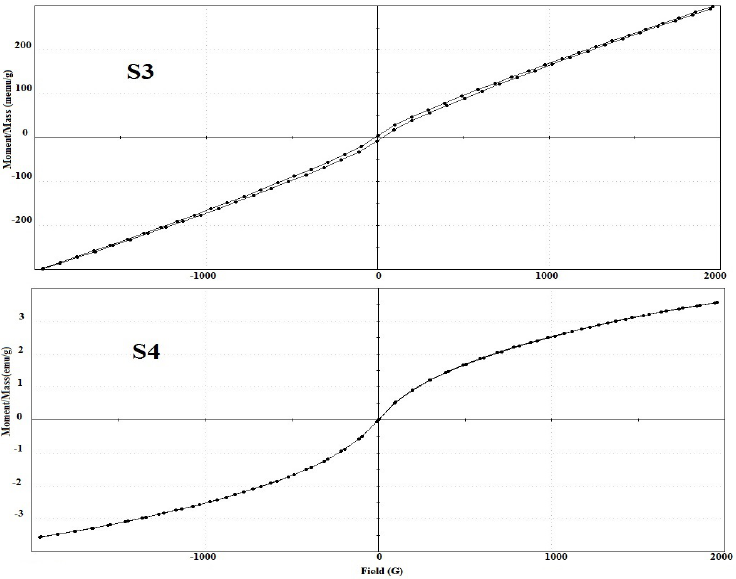
Figure 7. M - H curves for the S3 and S4 samples. Table 3. The magnetic properties (M s, M r , M r /M s , K a and H c ) of the S3 and S4 samples.